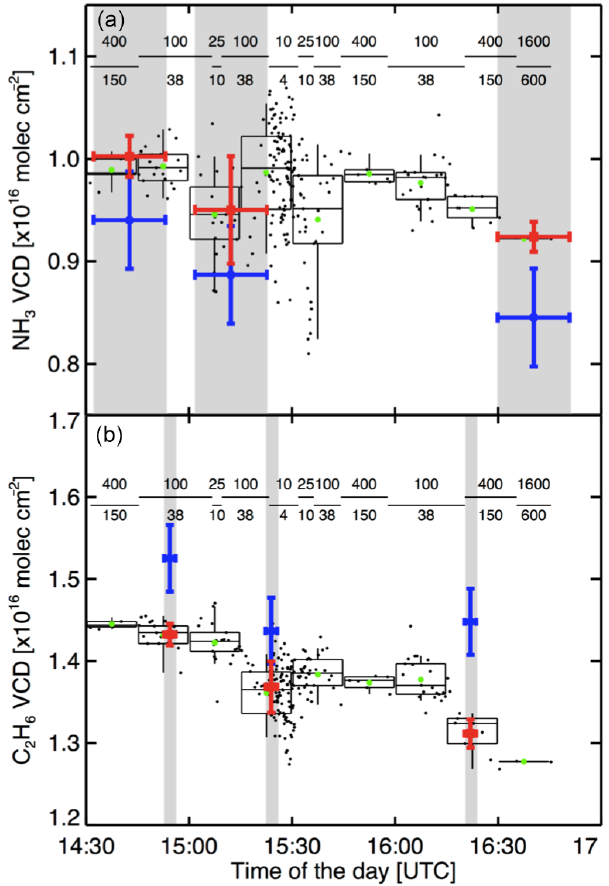
Figure 3. Assessment of CU mobile SOF accuracy at NCAR, Boul- der, CO: (a) NH 3 and (b) C 2 H 6 . Blue: measurements of the HR- NCAR-FTS; black: individual mobile SOF measurements (variable integration time); red: mobile SOF data averaged over the time pe- riod of the NCAR measurements (indicated in grey); green: 15min averages of mobile SOF data. The dashes indicate during which time period the individual mobile SOF measurements were taken. Numbers above the dashes indicate the internally co-added scan number and numbers below indicate the integration time of each stored spectrum in seconds. Boxes and whiskers represent 5th, 25th, median, 75th and 95th percentiles for every 15min. The VCD un- certainty on the mobile SOF and NCAR measurements is given as the 1 σ standard